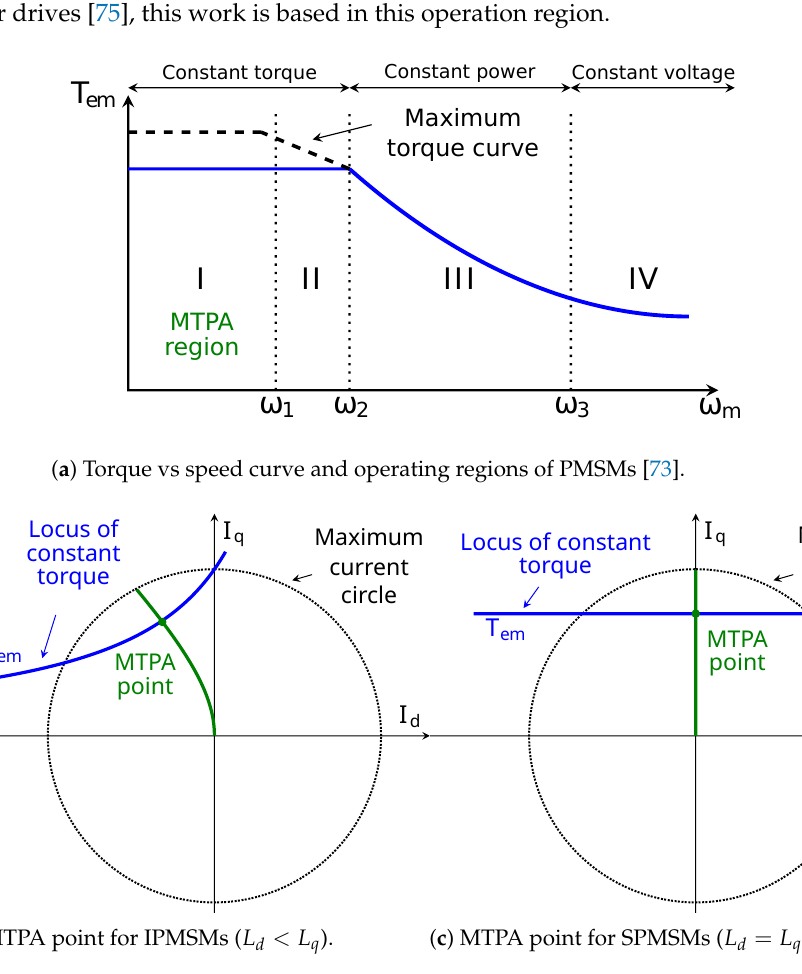
Figure 6. Characteristicregions for